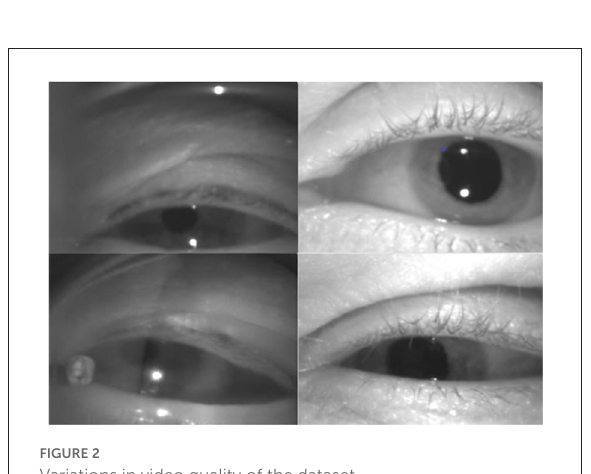
FIGURE2 Variations in video quality of the